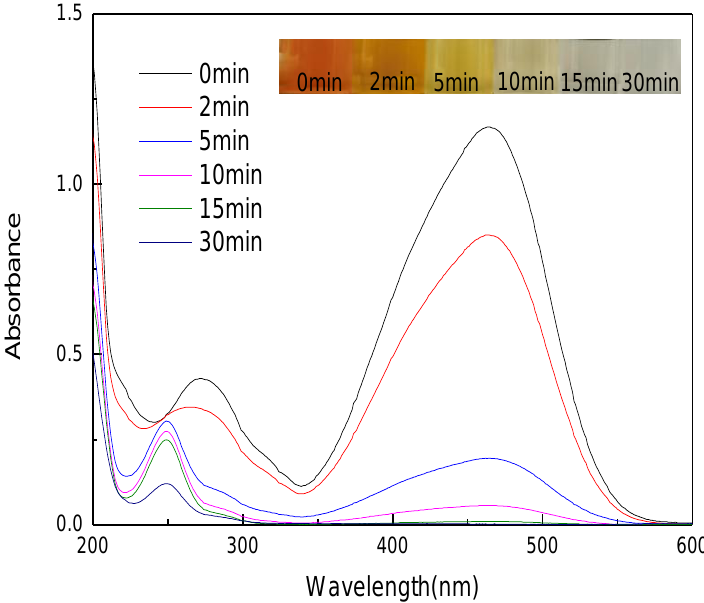
Figure 9. UV-VIS spectra of methyl orange during degradation by MEM (reaction temperature of 28 °C).